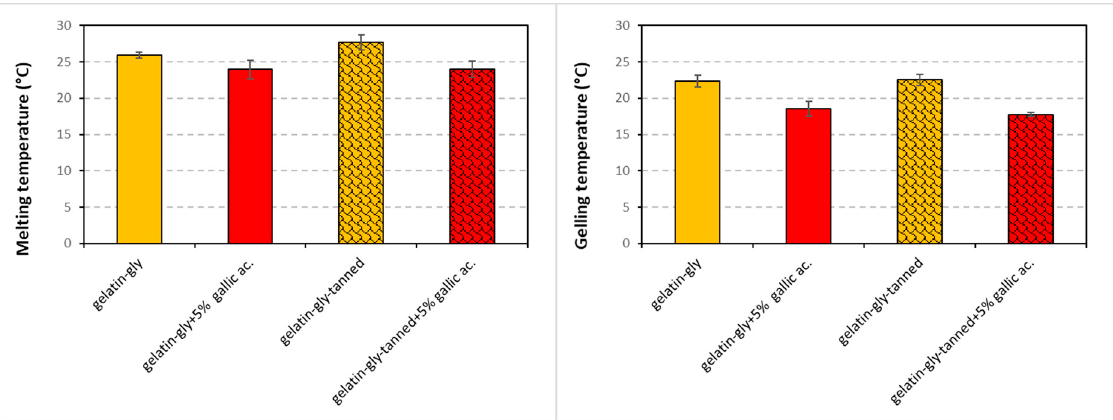
Figure 2. Influence of the composition of gelatin suspensions on their melting and gelling tempera- tures.